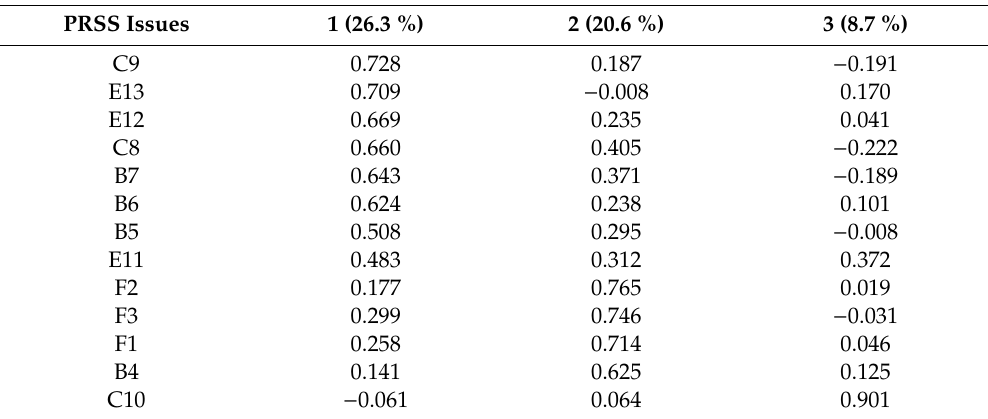
Table 8. Factor analysis of PRSS